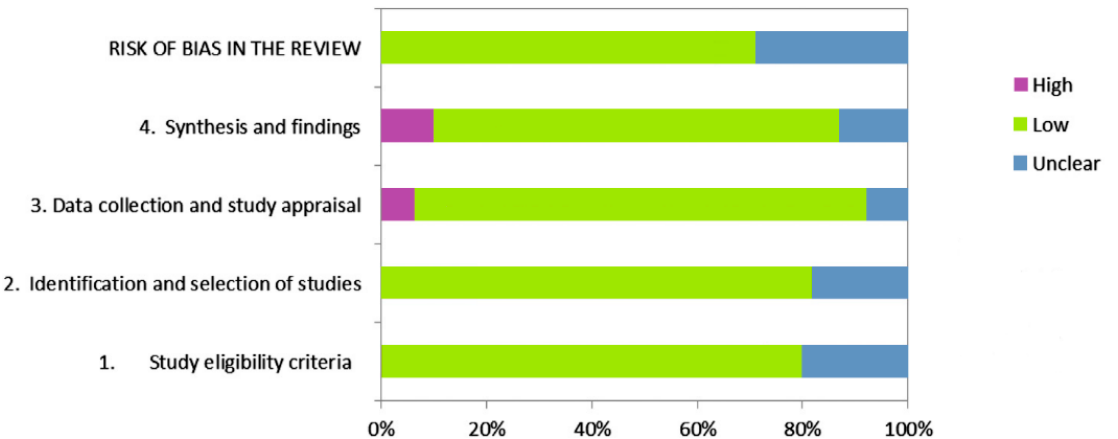
Figure 2. Graphical presentation for ROBIS results.